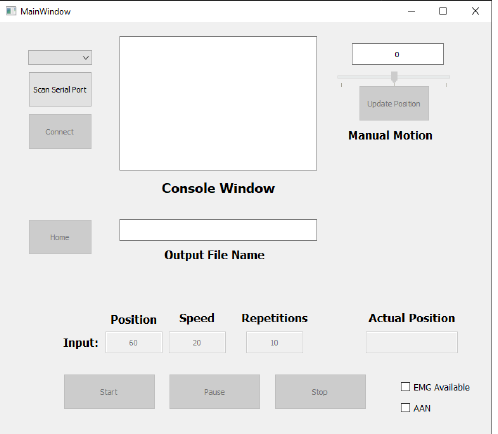
Figure 14. Python graphical user interface (GUI) to communicate with the